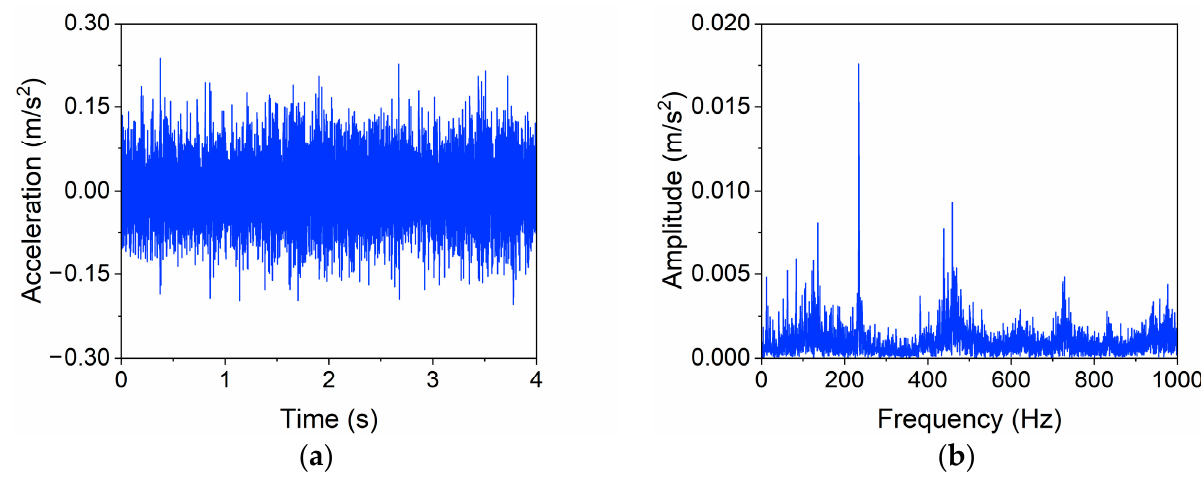
Figure 13. Representative signal before filtering. ( a ) Time domain, ( b ) Frequency domain.